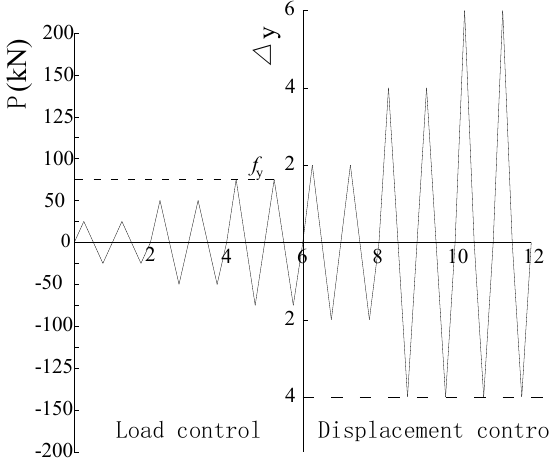
Figure 4. Loading method. Figure 4. Loading